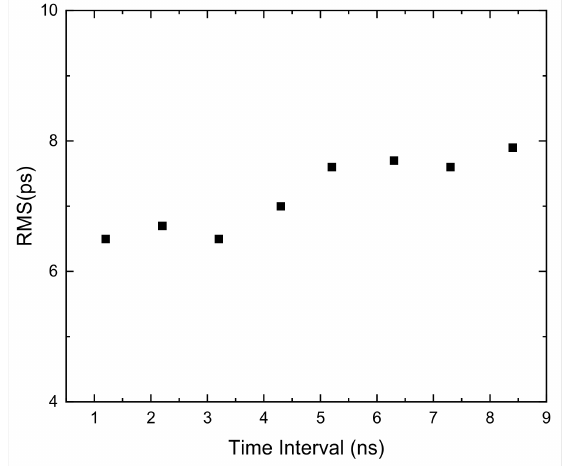
Figure 11. RMS precision of the 10-chain TDC with different time interval.